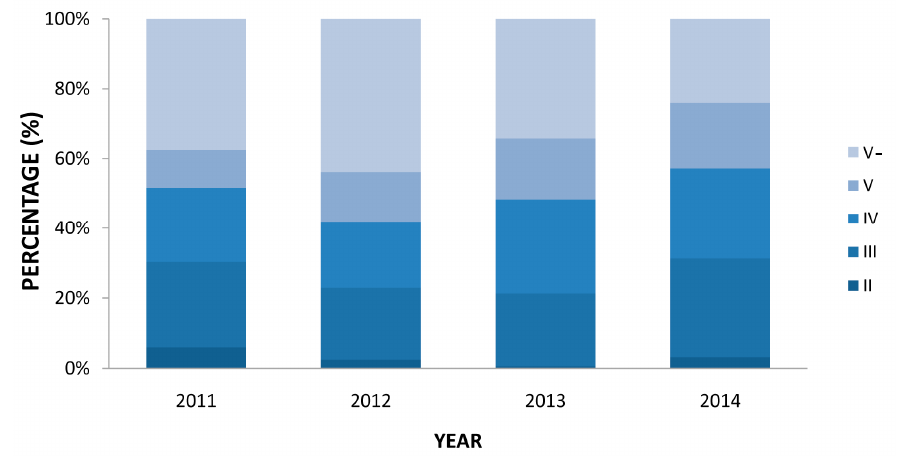
Figure 3. Temporal variation in water quality at boundaries from 2011 to 2014.